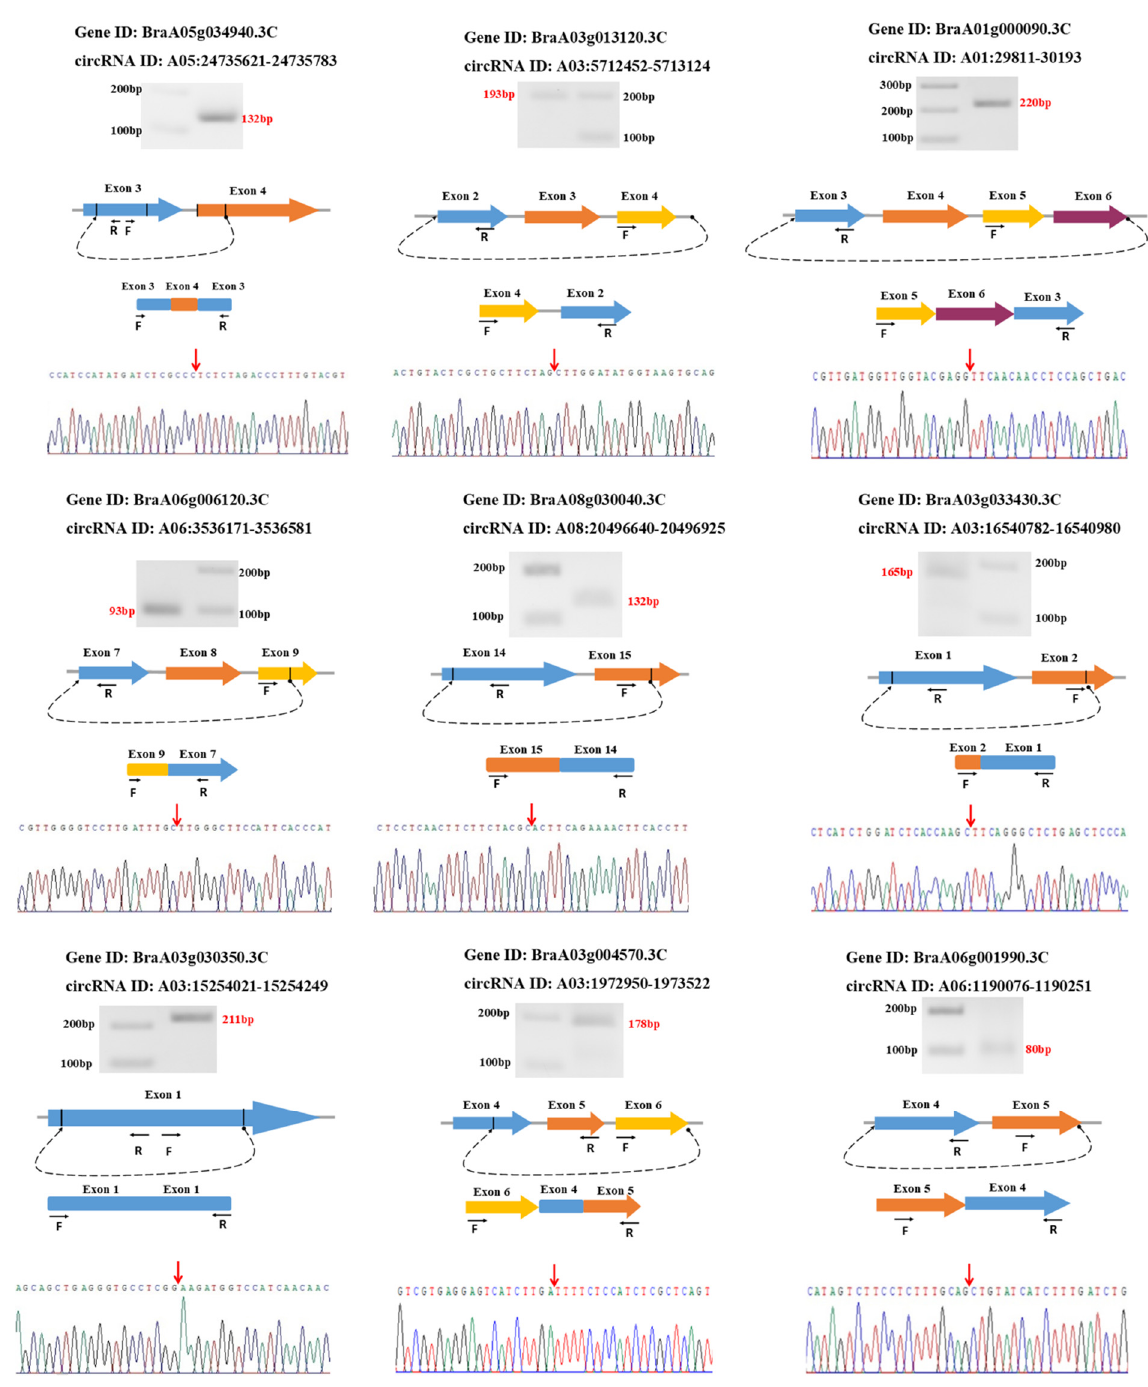
Figure 8. CircRNA validation using divergent primers and Sanger sequencing. From the top: the name of the circRNA parent gene, circRNA ID, the amplified band using divergent primers and cDNA, schematic representation of the genomic region of selected circRNAs and their amplified junction, dashed curved arrows represent head-to-tail back-splicing points, the two sets of arrows indicate the position of divergent primers on corresponding exons, conjunction validation using Sanger sequencing, and red arrows show the position of the junction point.